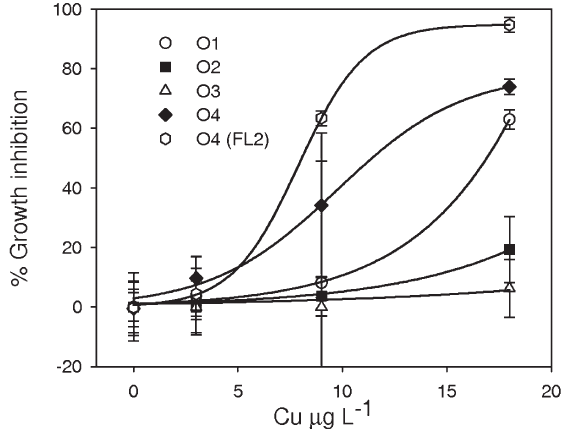
Fig . 7. – % of growth inhibition of oceanic populations due to cop- per exposure; O4 (FL2) refers to the population from sample loca- tion O4 that showed a strong phycoerythrin signal.